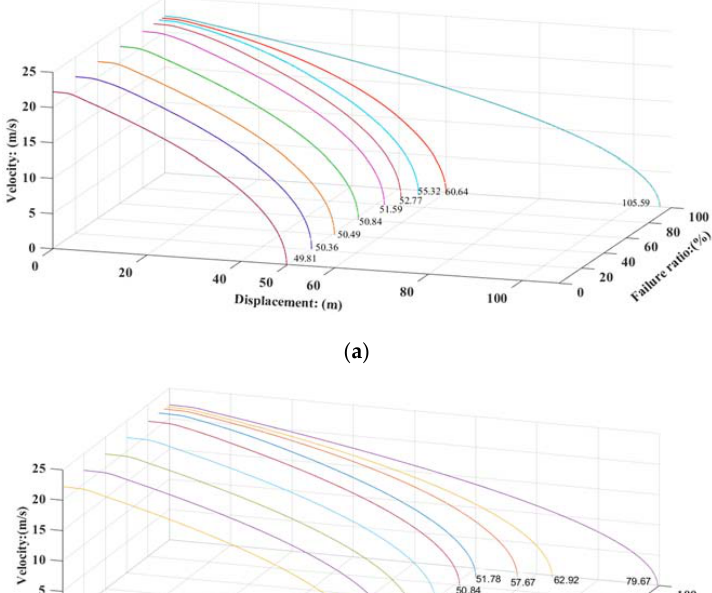
( d ) Figure 24. Pressure of brake chamber of different failure ratios. ( a ) mode 1 (FL); ( b ) mode 2 (RL); ( c ) mode 3 (FL); ( d ) mode 4 (FL). Mode 1 mainly affects the ability of the front brakes. The FL wheel was taken as an example for analysis. From curves as shown in Figures 23a and 24a, it can be seen that the relationship between the braking distance and the failure ratio is nonlinear. When the failure ratio reaches over about 80%, the braking distance increases quickly. From the curves of pressure, it can be seen that the greater the failure ratio, the more obvious the throttling effect of the pipeline, the slower the pressure increase, and the more the ABS intervention time lags. The peak adhesion coefficient can not be utilized effectively, so the braking ability is reduced. In mode 0 , the ABS intervention time is about 0.3 s. When the failure ratio reaches 90%, the ABS intervention time is about 0.9 s. In case of complete failure, the air flow becomes zero and the front brake completely loses braking capacity.